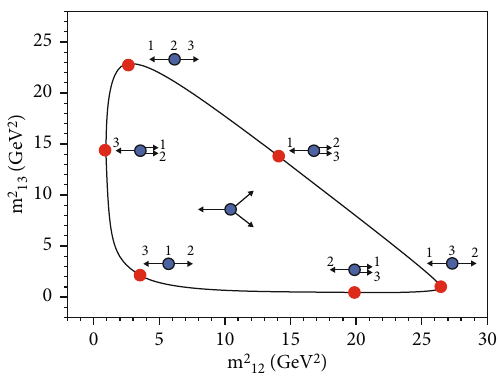
Figure 1: Phase space of the three-body decay B − ⟶ K + K − π − in terms of the invariants m 12 and m 13